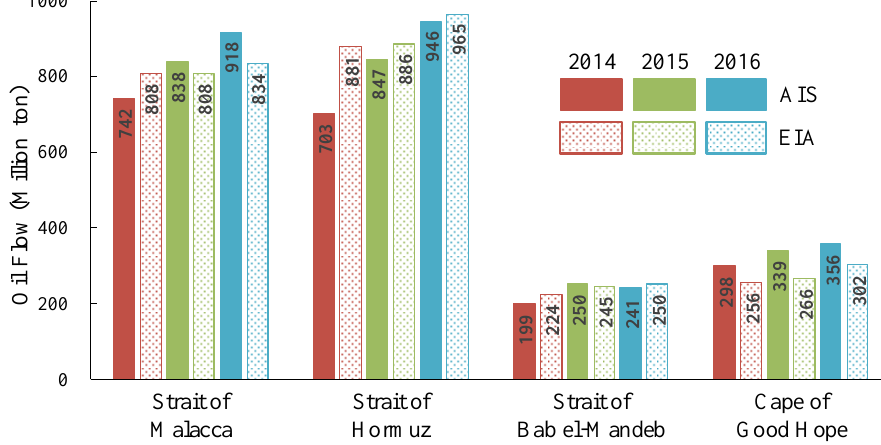
Figure 6. Annual oil flow through maritime oil chokepoints (MOCs) compared with the Energy Information Administration (EIA) data. Table 3. Ratio (%) of the annual oil flow estimated in this study compared to the EIA data of the MOCs.